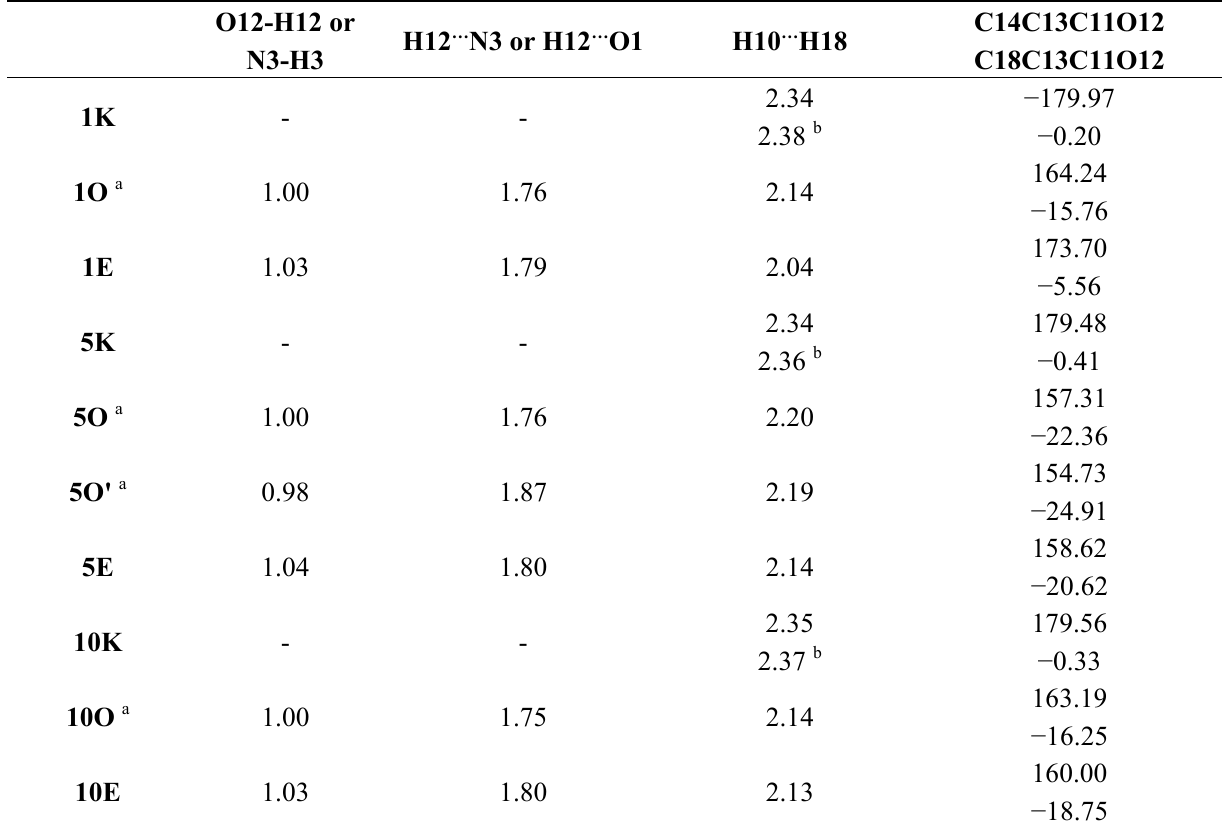
Table 6. Optimized (MP2/aug-cc-pvdz) bond lengths (Å) and bond and dihedral angles (deg) for 2-phenacylbenzoxazoles and their